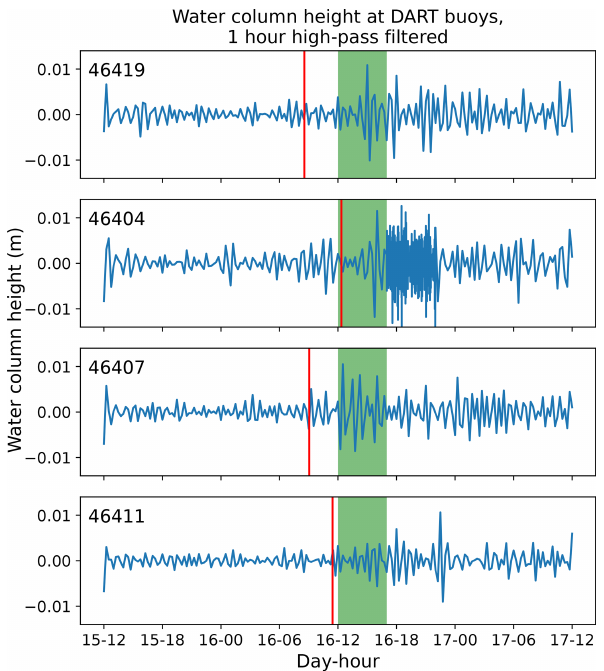
Figure 10. Water column height deviations (1h high-pass filtered) at DART sensors from 15 January, 12:00, to 17 January, 12:00, in 2016. Vertical red lines represent 08:33, 12:21, 09:03, and 11:27 on 16 January from top to bottom, i.e., the approximate onset of un- usual water level fluctuations at the tide gages. Green bars indicate the time period during which videos of large runup and injury re- ports took place, i.e., between 16 January 12:00, and 16 January, 17:00. Between approximately 16 January, 17:00, and 16 January, 22:00, the 46404 station was in higher sampling